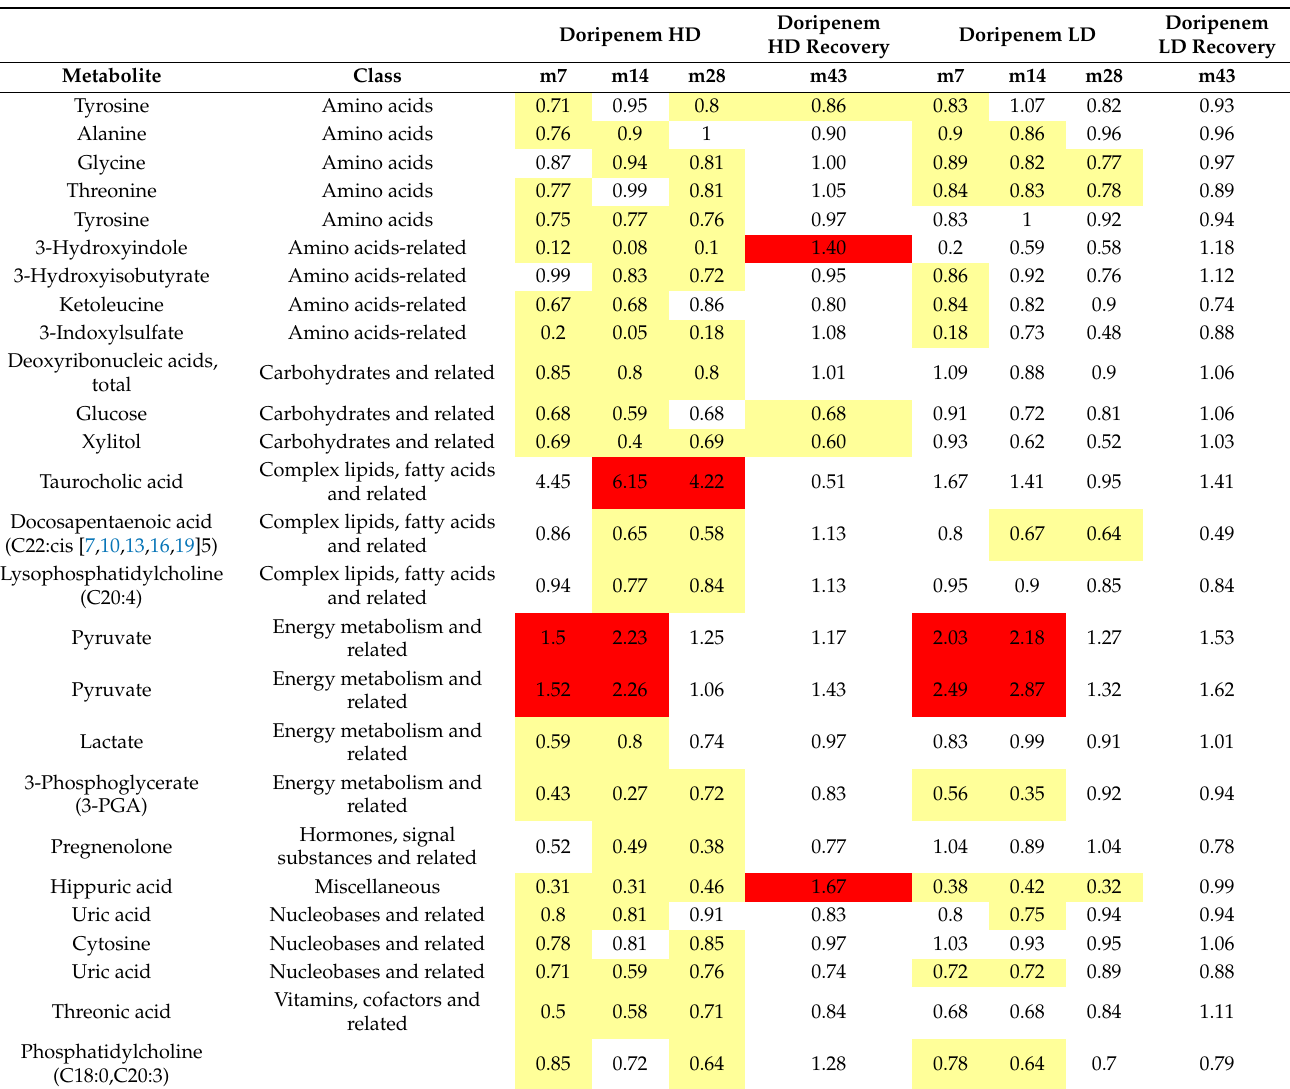
Table 12. Doripenem-induced plasma metabolite fold changes in male (m) Wistar rats (N = 5 per group) dosed with 100 (LD) and 1000 (HD) mg/kg bw/day observed on days 7, 14, and 28 (m7, m14, and m28) and on day 42 (m42) for the doripenem-recovery group. Statistically significant changes (Welch t -test; p -value < 0.05) are shown where red boxes mean a significant increase, yellow boxes mean a significant decrease, and white boxes indicate an insignificant change in the respective plasma metabolites compared to control